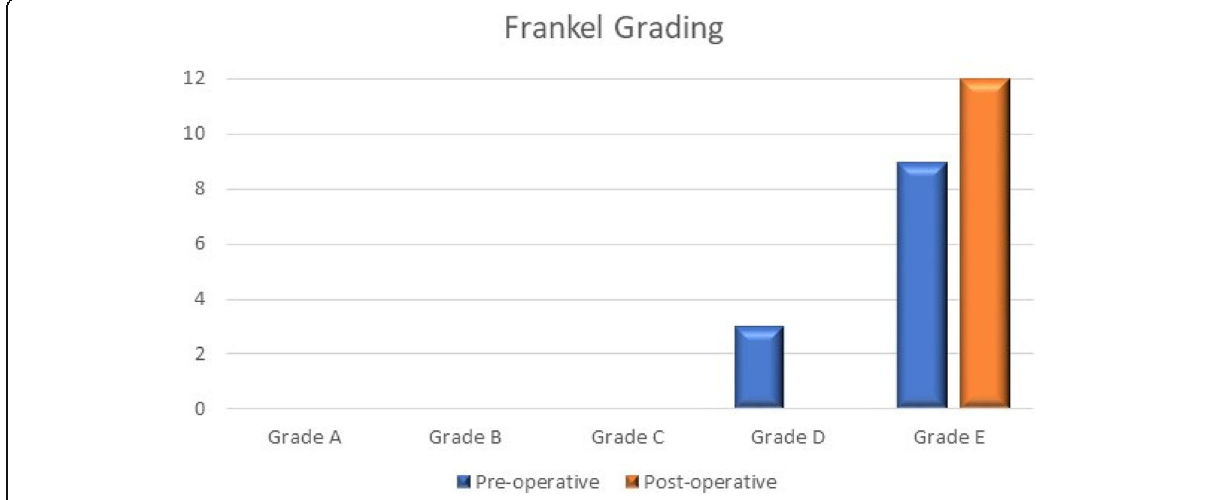
Fig. 10 Improvement in neurological condition using the Frankel grading